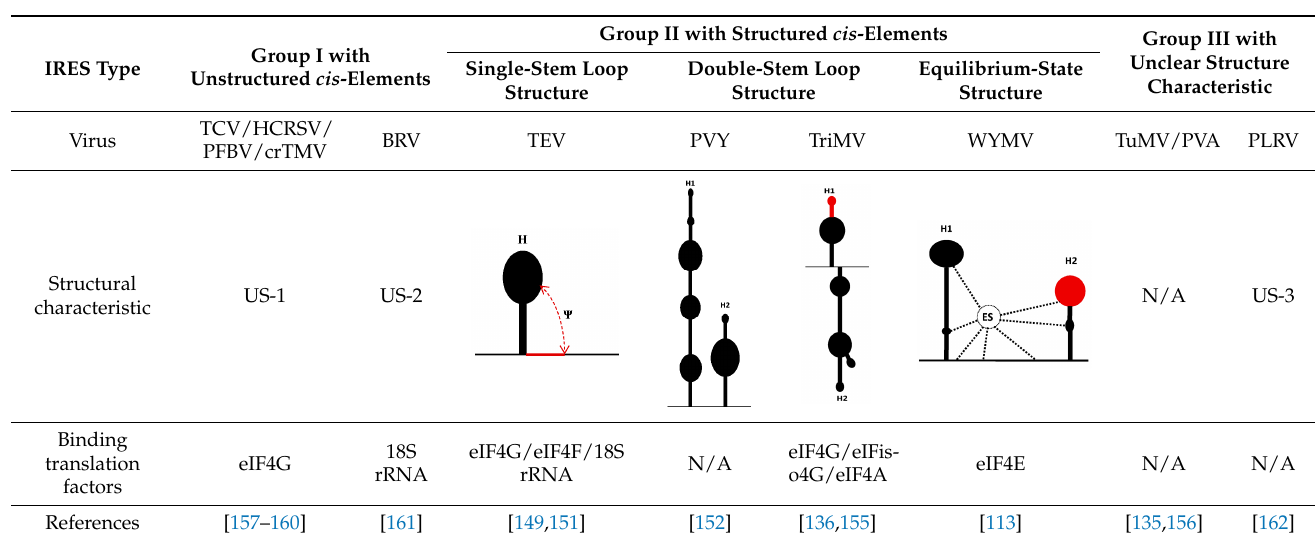
Table 2. Summary of IRESes in plant RNA viruses.